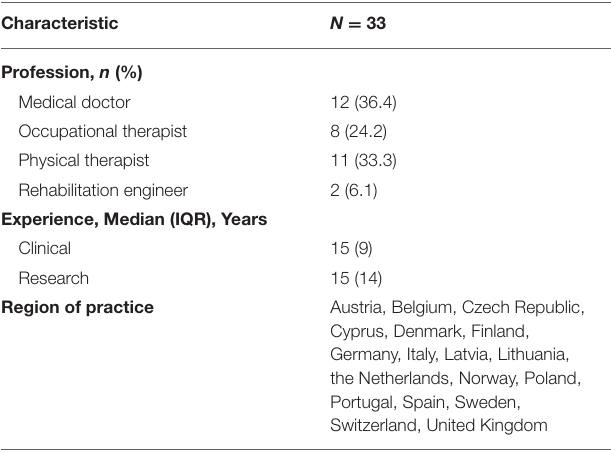
TABLE 1 | Participant